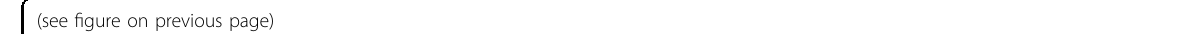
Fig. 8 HCQ enhanced the antitumor effect of FX11 in vitro and in vivo. A B-CPAP cells with stable LDHA knockdown were treated with the autophagy inhibitor hydroxychloroquine (HCQ). Western blotting was used to detect p62 and LC3BII/I levels. B Apoptosis of B-CPAP cells exposed to 10 μ M of FX11 for 24 h with/without HCQ (10 μ M for 24 h) was detected by fl ow cytometry. The data are expressed as the mean ± SD. C B-CPAP cells were exposed to FX11 (10 μ M for 24 h) with/without HCQ (10 μ M for 24 h), and western blotting was used to detect cleaved caspase 3 levels. D FX11 (3 mg/kg) with/without HCQ (60 mg/kg) was given to mice bearing papillary thyroid tumors for 21 days. Tumor weights were measured on day 30 E , and tumor volumes F are presented with growth curves. The data are presented as the mean ± SD. G H&E staining and representative IHC images of cleaved caspase 3 expression and Ki-67 staining of xenografted tumor specimens from the FX11 with/without HCQ groups are shown. All * p < 0.05, ** p < 0.01, *** p <